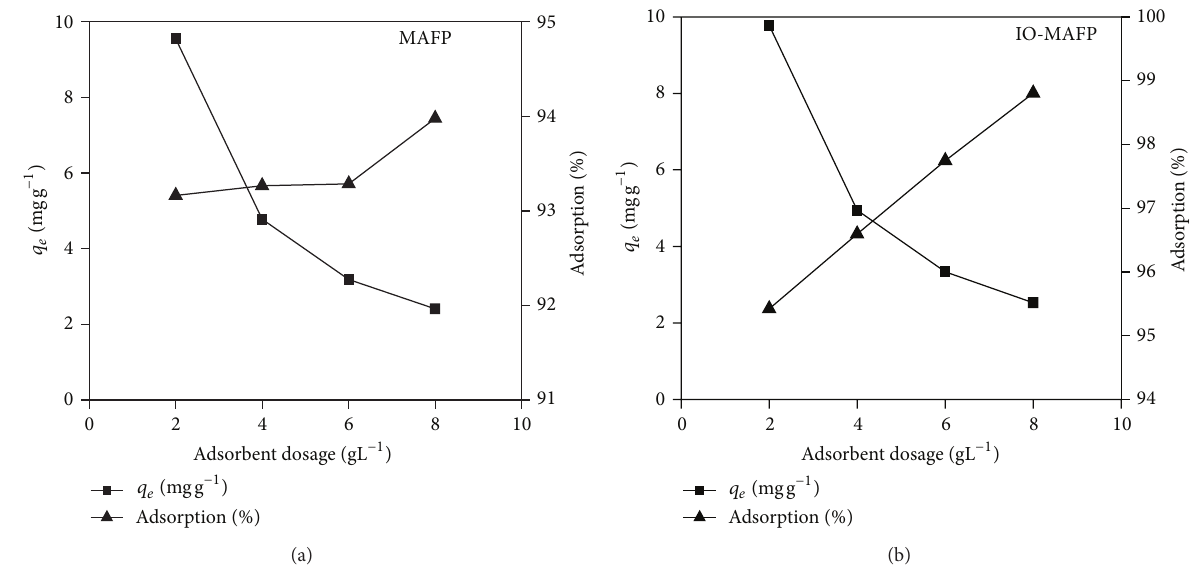
Figure 6: Biomasses, MAFP, and IO-MAFP dosage effect on sorption of Co(II).